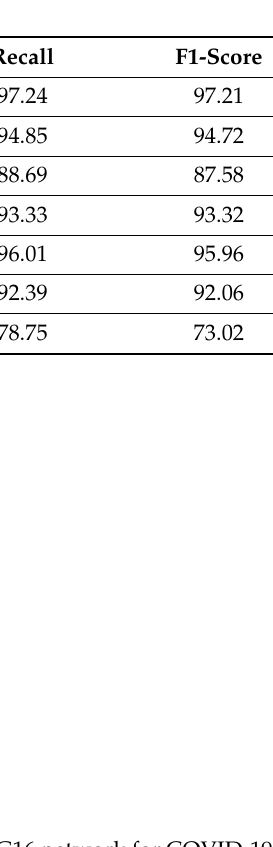
Figure 4. Training and validation accuracy of best performing VGG16 network for COVID-19 and normal class.